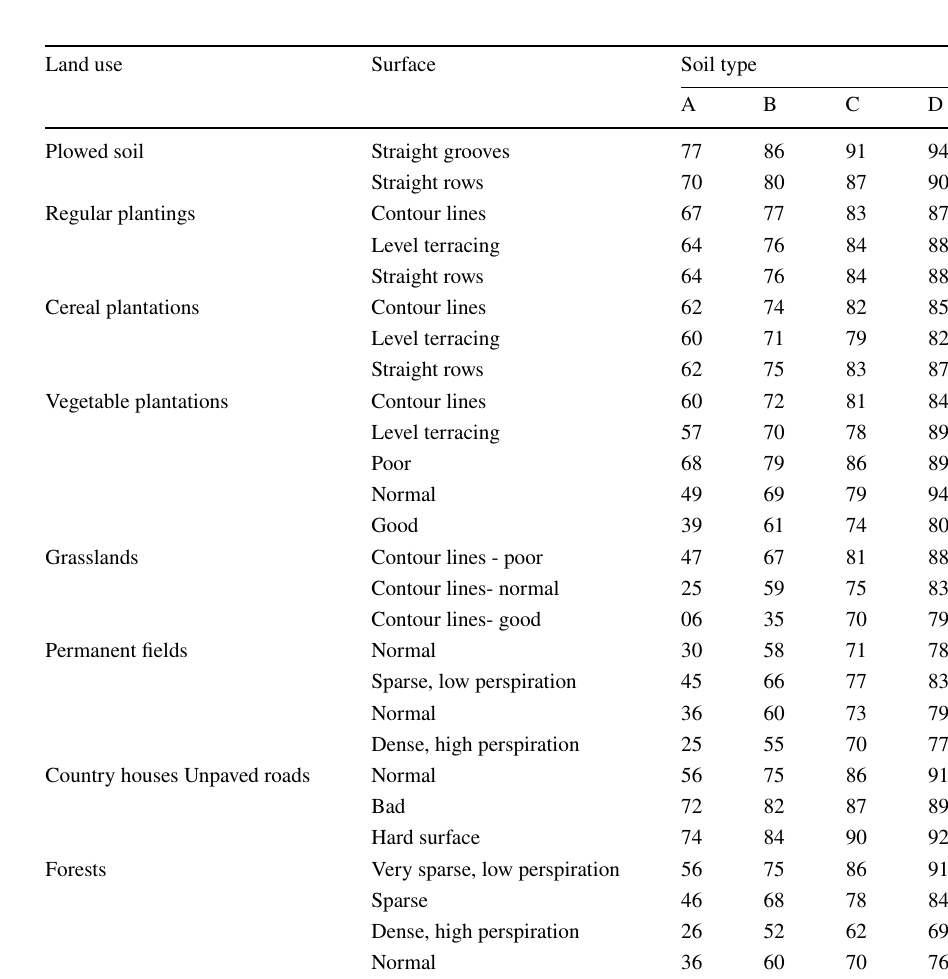
Table 1 Classification of soil hydrogeological groups (Canholi 2014) Soil group Characteristics A